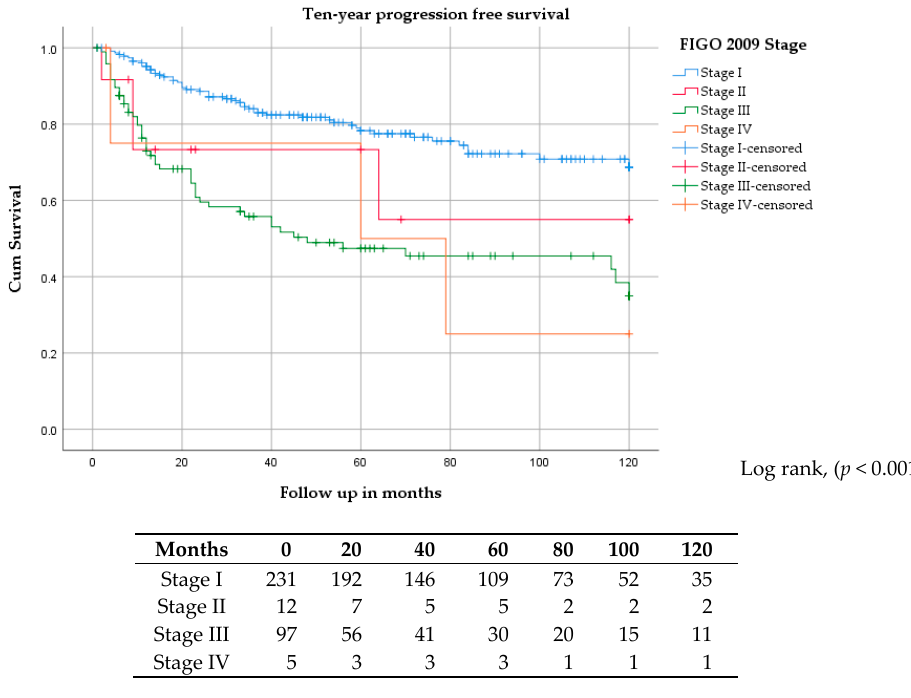
Figure 1. Kaplan–Meier curve for ten-year progression-free survival stratified by FIGO stage.